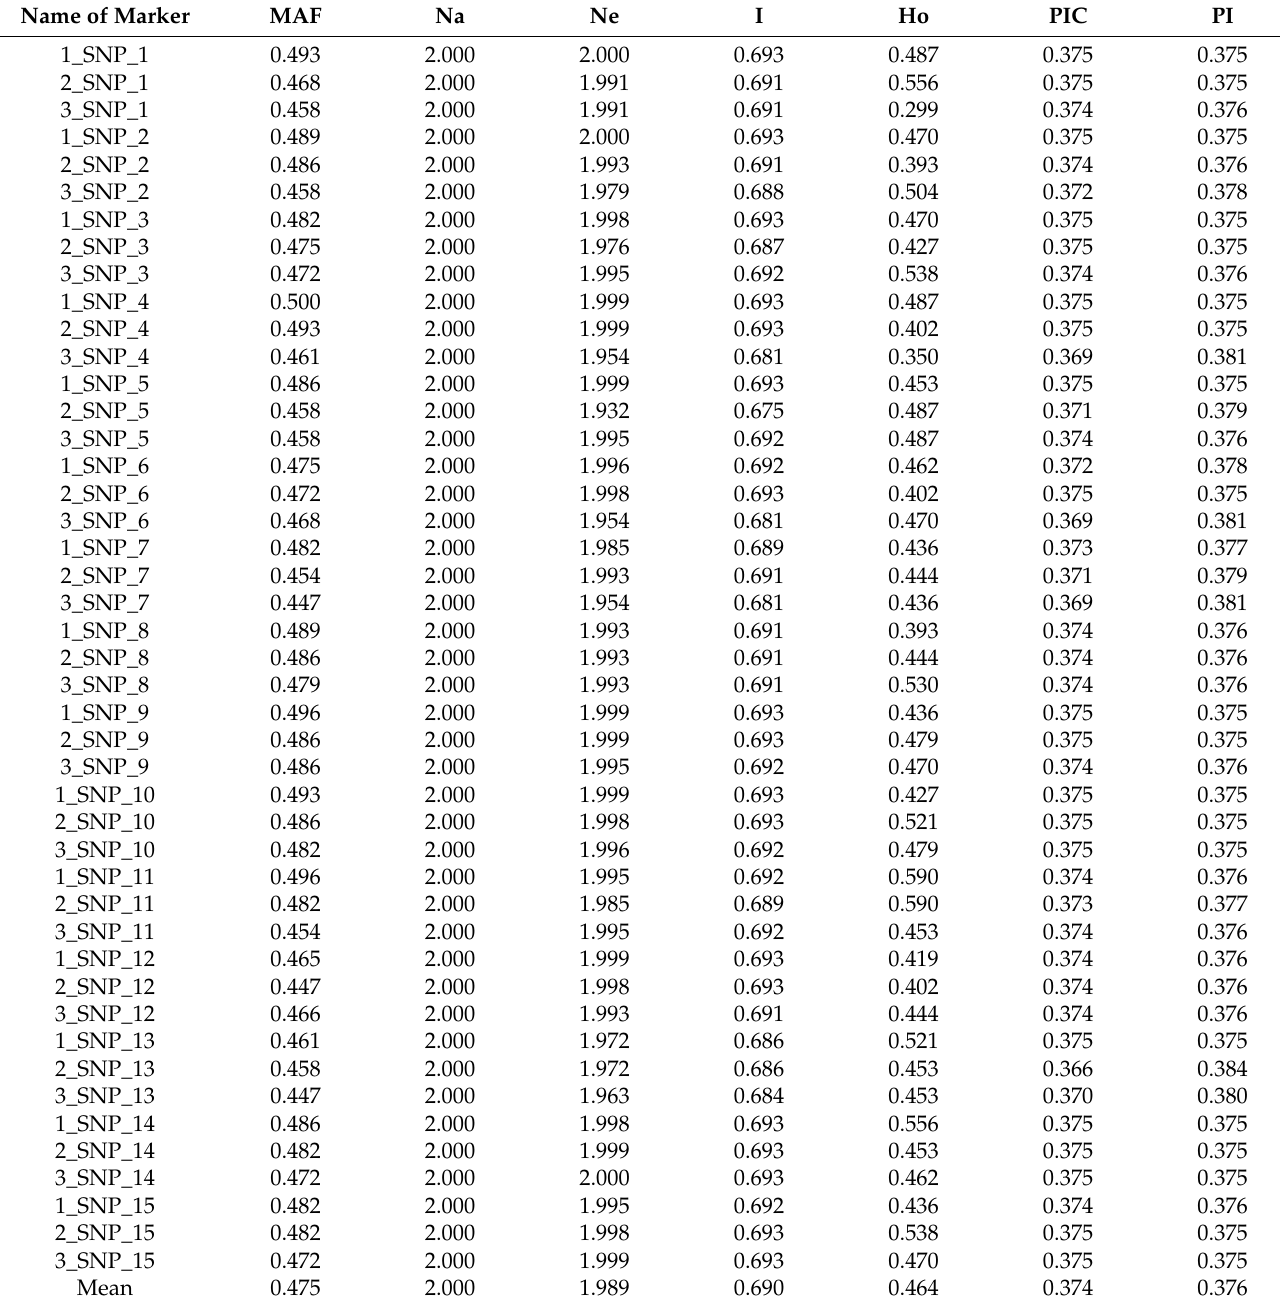
Table 2. Genetic diversity parameters of 45 SNP loci in 117 tea